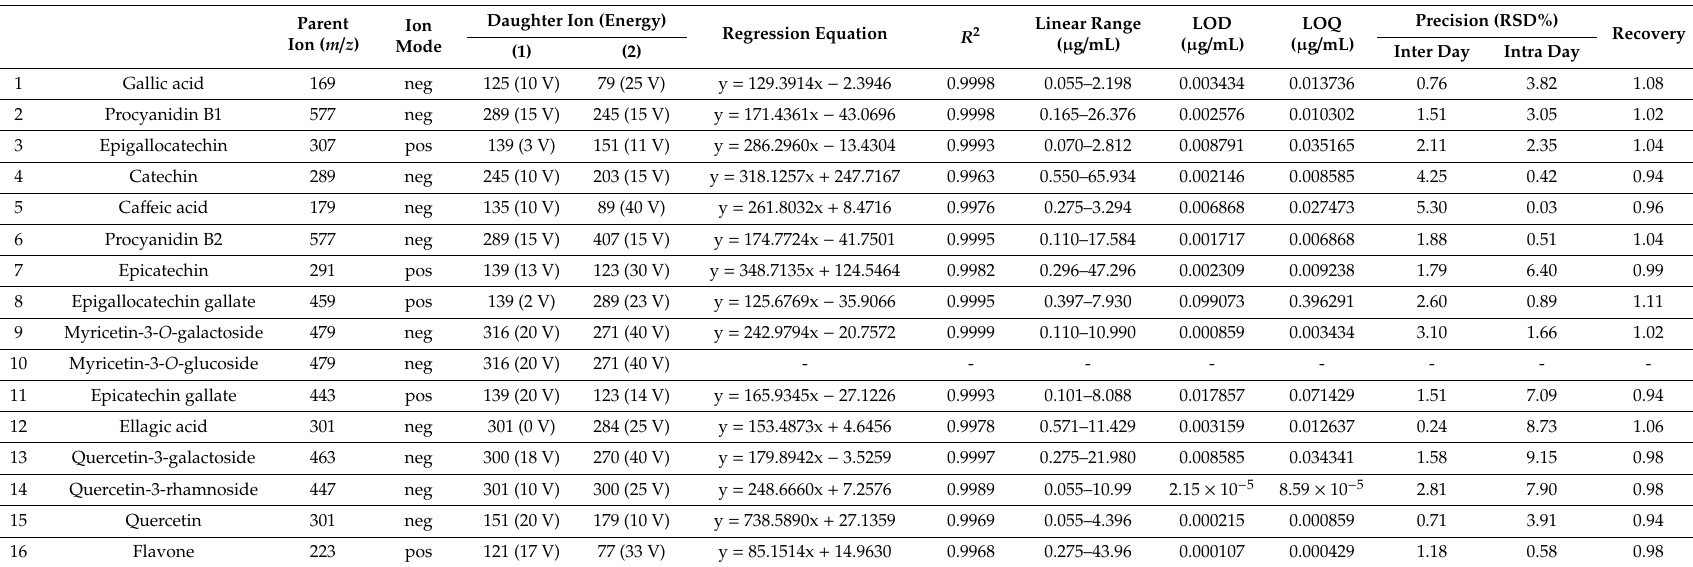
Table 3. Accuracy and precision of the qualification and quantification method of phenolic